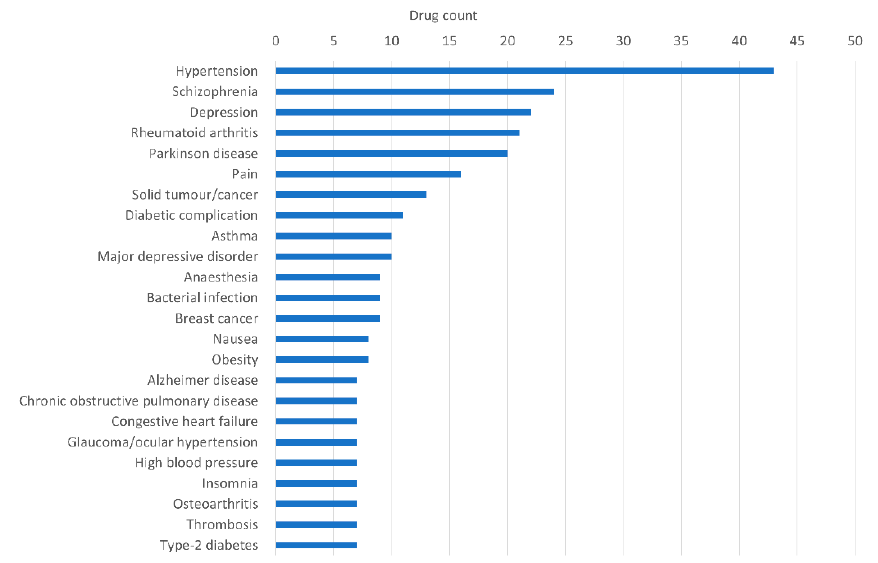
Figure 3. Distribution of the original medical indications of drugs predicted to be repurposable for AD. Bar plot of the top 30 original medical indications with at least five associated drugs, retrieved from TTD